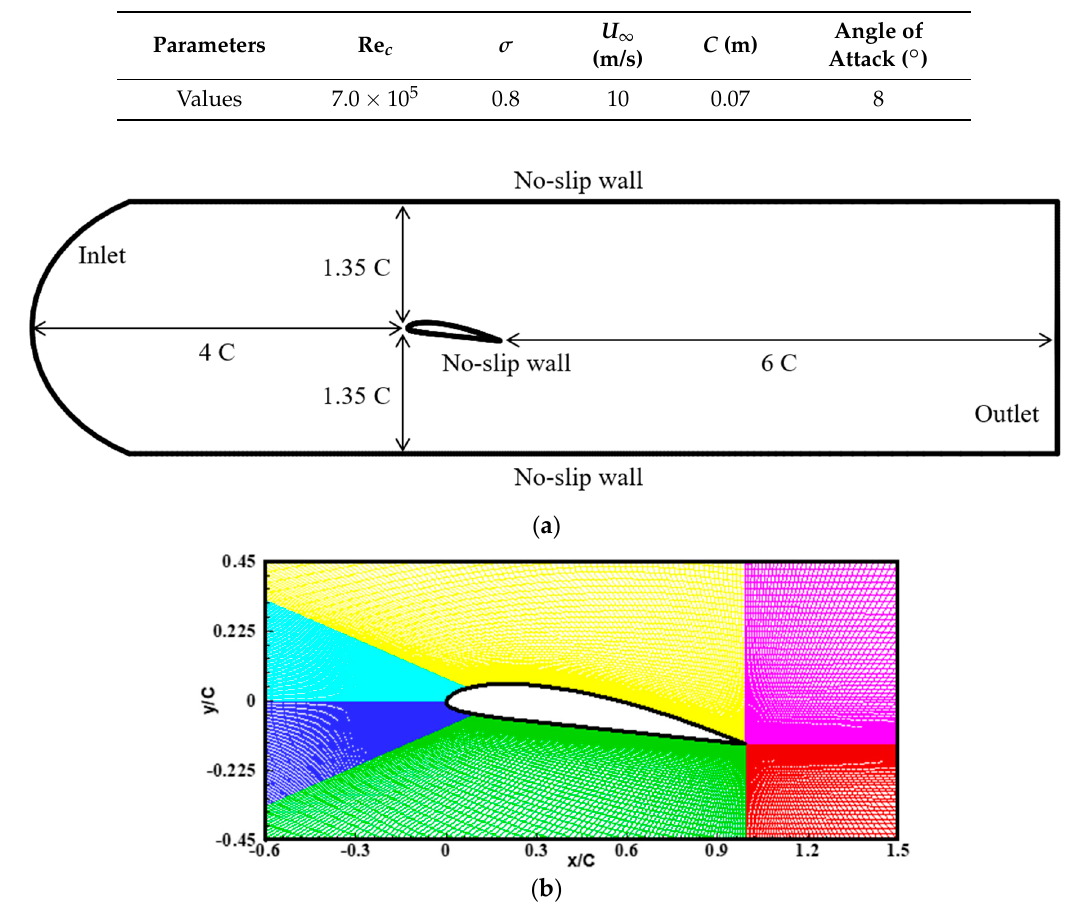
Figure 1. ( a ) Computational domain and ( b ) zoomed grid system.